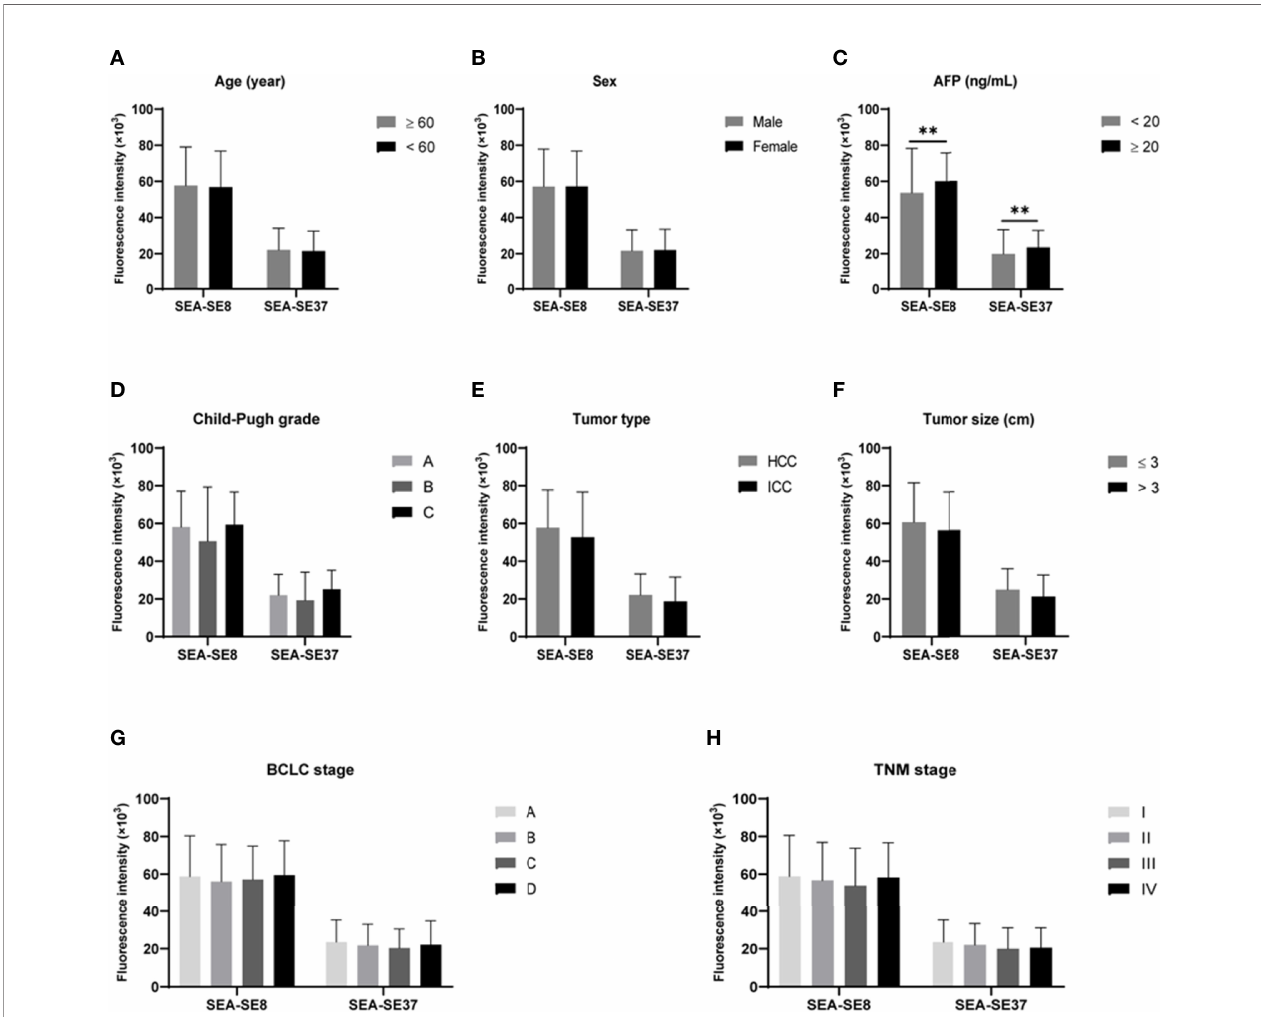
FIGURE 7 | Comparisons of aptamer-related fl uorescence indicators SEA-SE8 and SEA-SE37 between subgroups derived from various clinicopathological characteristics of primary hepatic carcinoma. ** P < 0.01. (A) Subgroups of age. (B) Subgroups of sex. (C) Subgroups of AFP levels. (D) Subgroups of Child-Pugh grade. (E) Subgroups of tumor pathological type. (F) Subgroups of tumor size. (G) Subgroups of BCLC stage. (H) Subgroups of TNM stage. SEA-SE8 or SEA-SE37: the difference of fl uorescence intensity at 8°C or 37°C measured after serum incubated with EvaGreen and aptamer and after serum reacted with EvaGreen. AFP, alpha- fetoprotein; BCLC, Barcelona Clinic Liver Cancer; TNM, Tumor, Node,